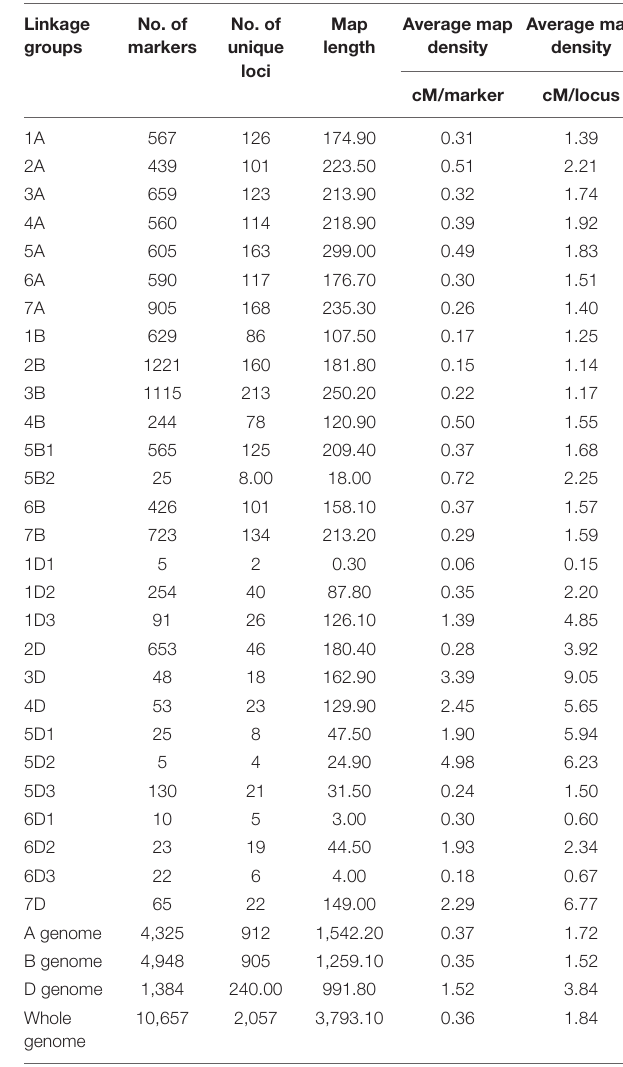
TABLE 3 | Correlation coefficients between five agronomic traits in the RIL population (Reeder × Albany) in six environments (Env.) and the overall mean across environments (M).